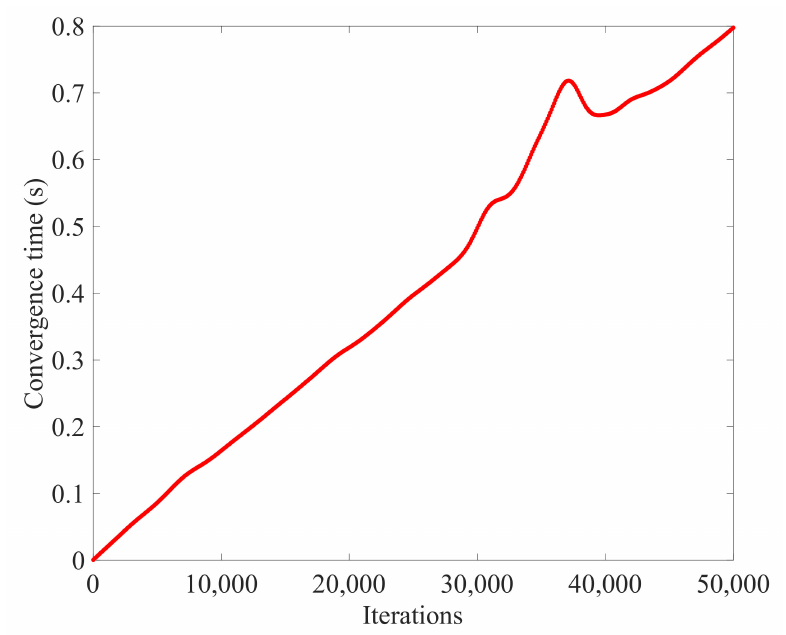
Figure 4. Convergence time as a function of the number of iterations.